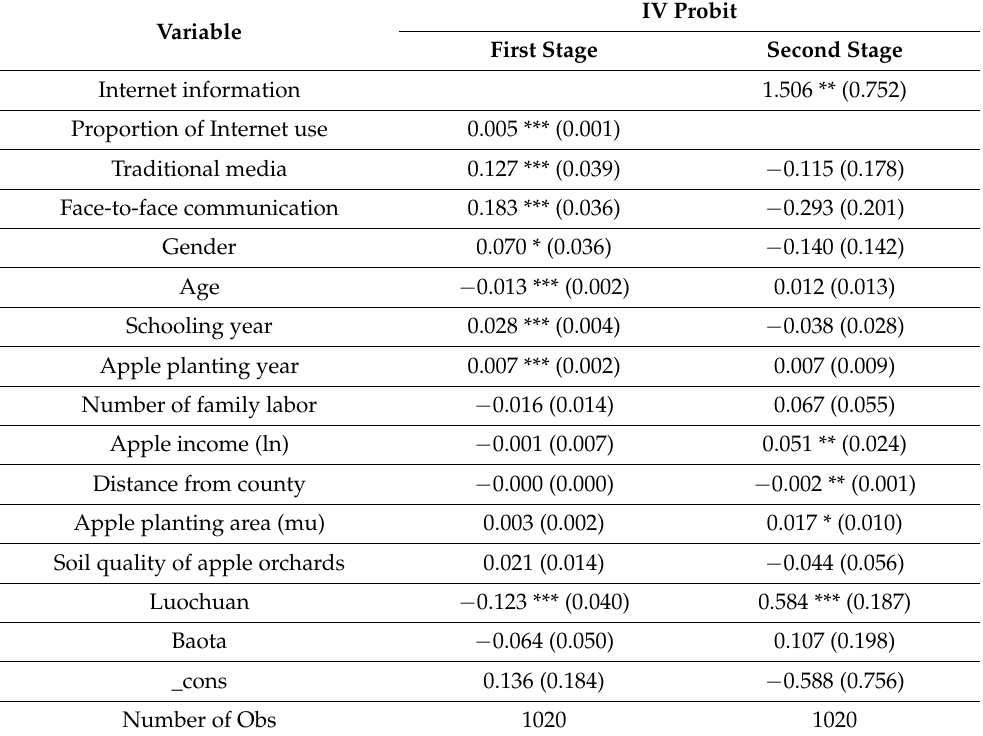
Table 5. The effect of the Internet information on anti-frost adaptive behavior of apple